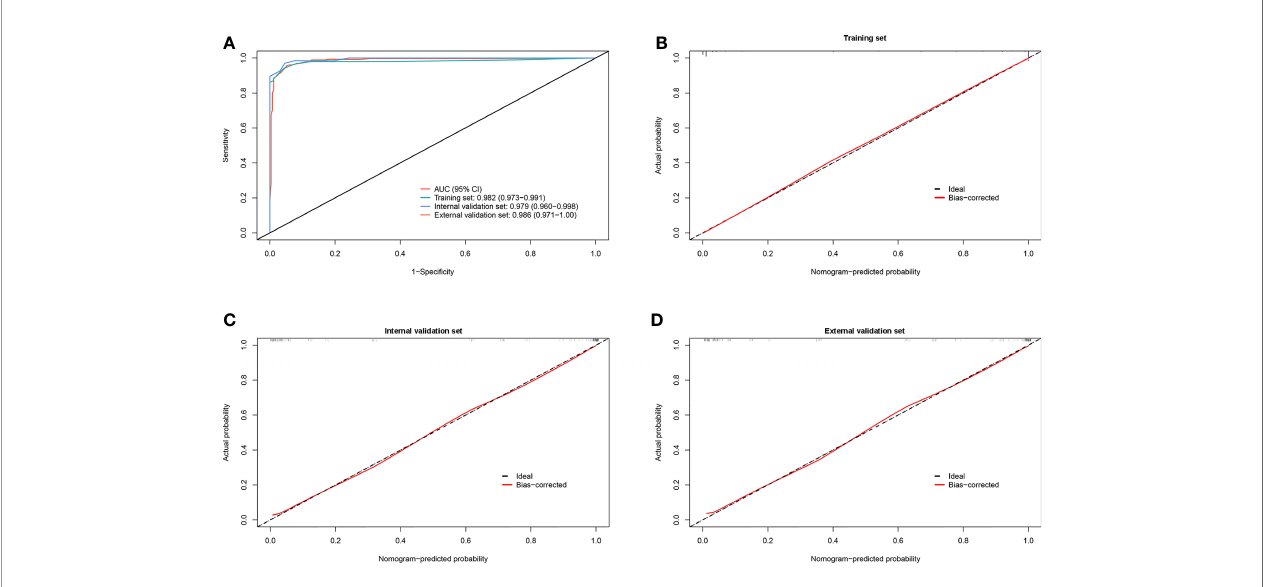
FIGURE 4 | Discrimination and calibration of the scoring system for identifying lung cancer with pleural effusion (PE) from tuberculous pleurisy effusion (TPE). (A) Receiver operating characteristic (ROC) curves of the scoring system in the training, internal validation, and external validation sets. (B – D) Calibration plots of the scoring system in the training, internal validation, and external validation